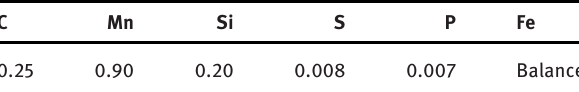
Table 1: Chemical composition of failed tube.